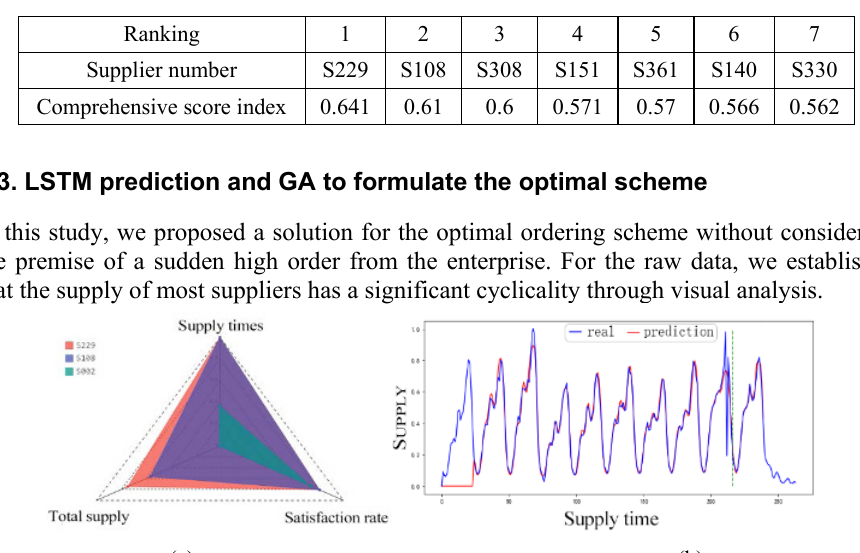
Table 1. Supplier quantitative evaluation results.